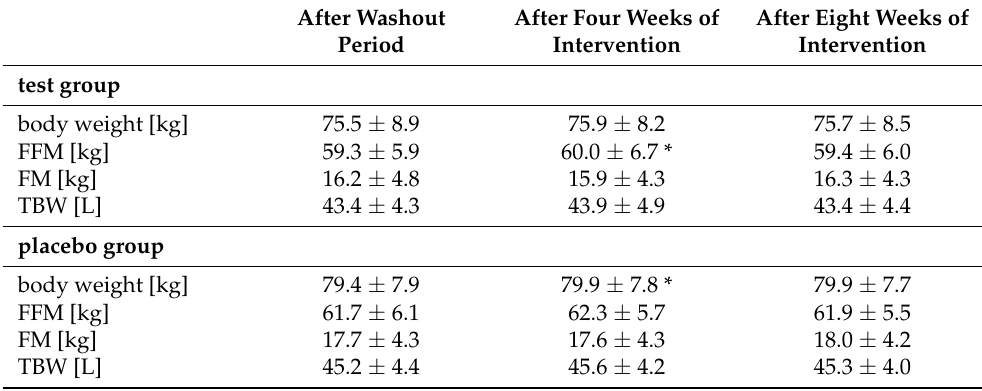
FFM: fat-free mass; FM: fat mass; TBW: total body